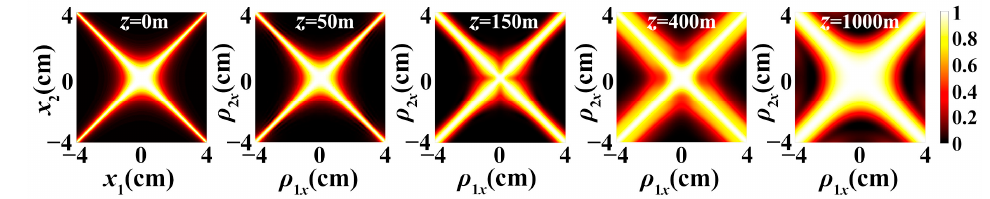
Figure 3. Evolution of the normalized spectral DOC on propagation in free space.